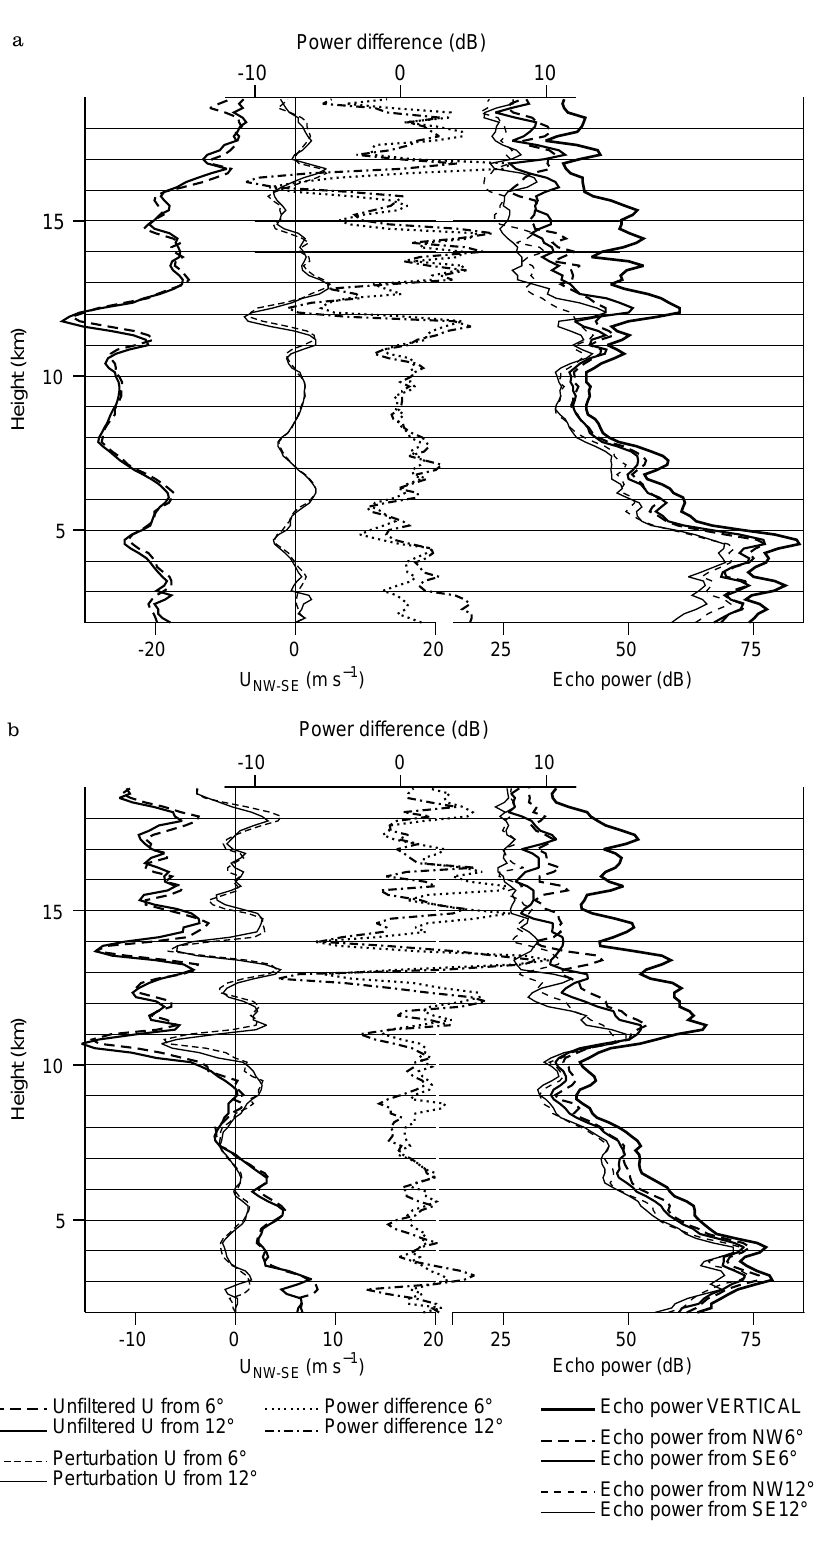
Fig. 5a, b. As Fig. 4, for a 0130–0230, 8 March 1994; b 1930–2030, 2